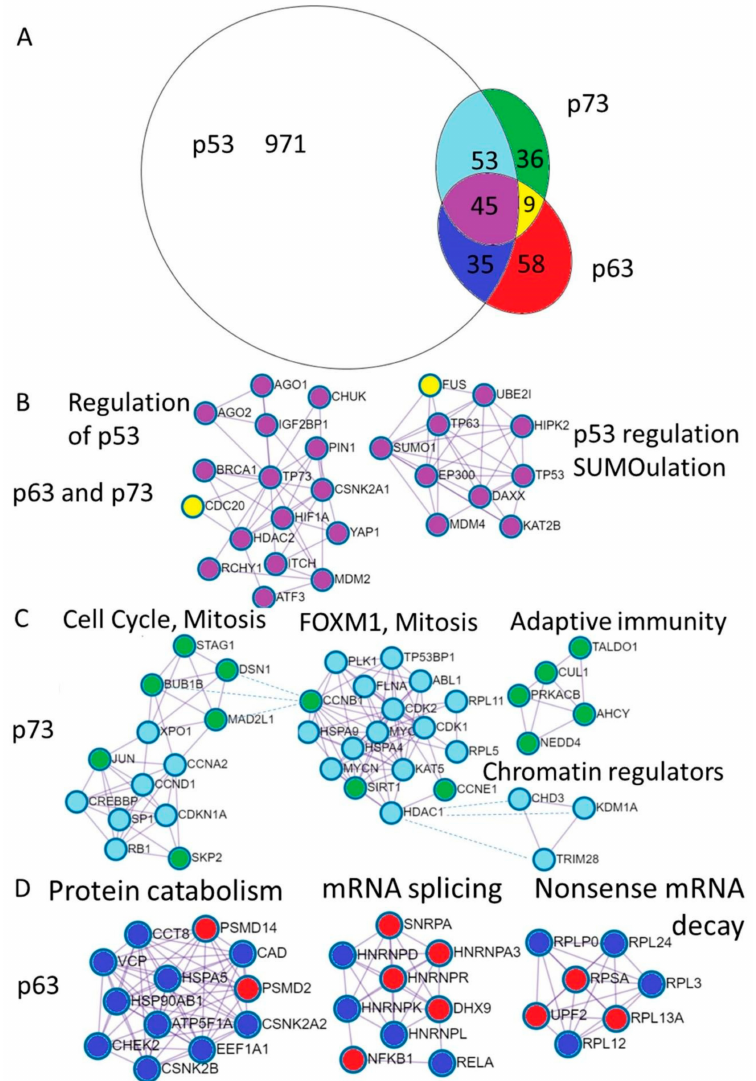
Figure 3. Annotation of the unique p73 and p63 protein interactions reveal distinct physiological functions. ( A ). Euler diagram of the p53, p63, and p73 protein interactions from the BioGrid database. Coloring of the Euler diagram